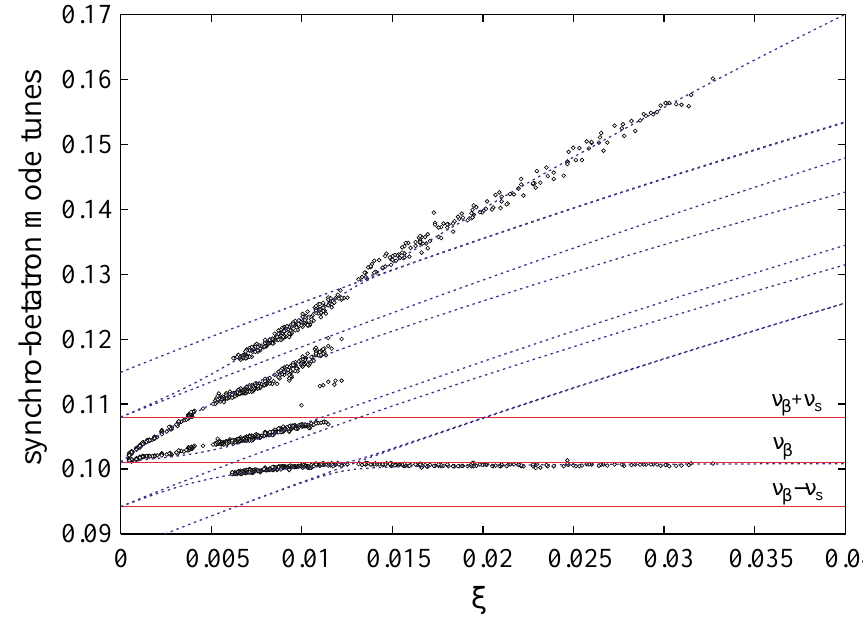
FIG. 6. (Color) Synchrobetatron mode tunes vs the beam-beam parameter j per one IP. Experimental data (circles) and simulation (lines). VEPP-2M was operated with one e 1 and one e 2 bunch colliding at two IPs, n b (cid:1) 0.101 , n s (cid:1) 0.0069 , b (cid:1) (cid:1) 6 cm, and the bunch length was 3.5